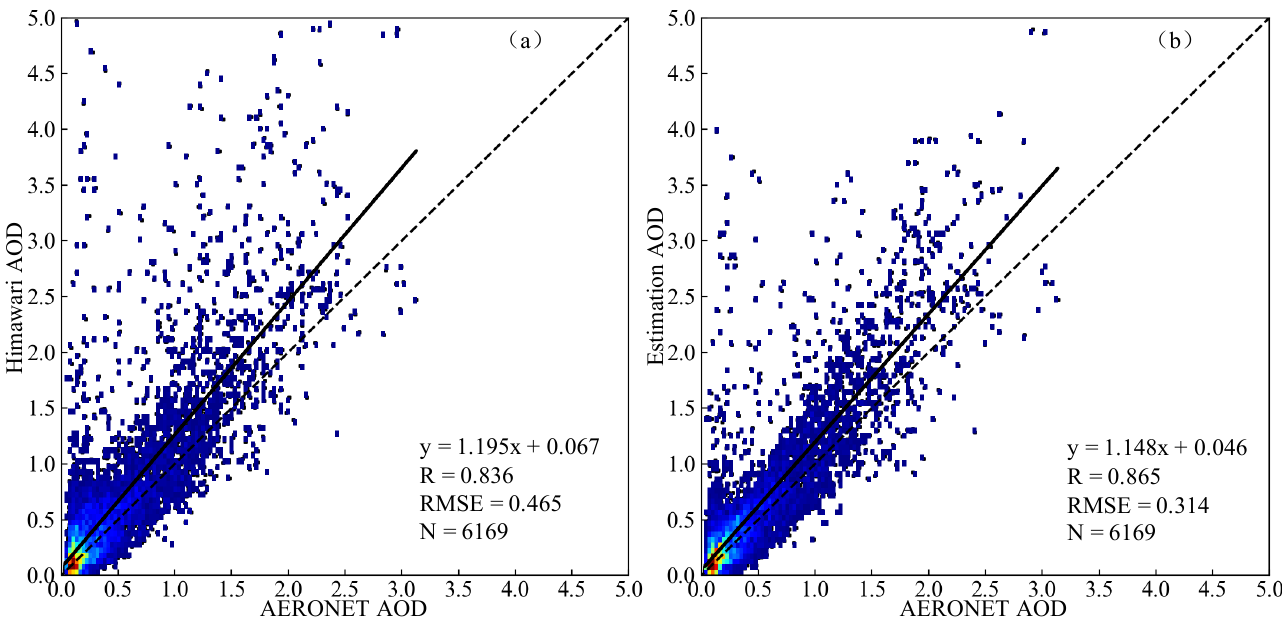
Figure 6. Correlation analysis of all the five AERONET sites daytime hourly observation in 2017. ( a ) the original Himawari 5 km AOD against AERONET AOD; ( b ) the estimated Himawari 1 km AOD against AERONET AOD. AOD at 500